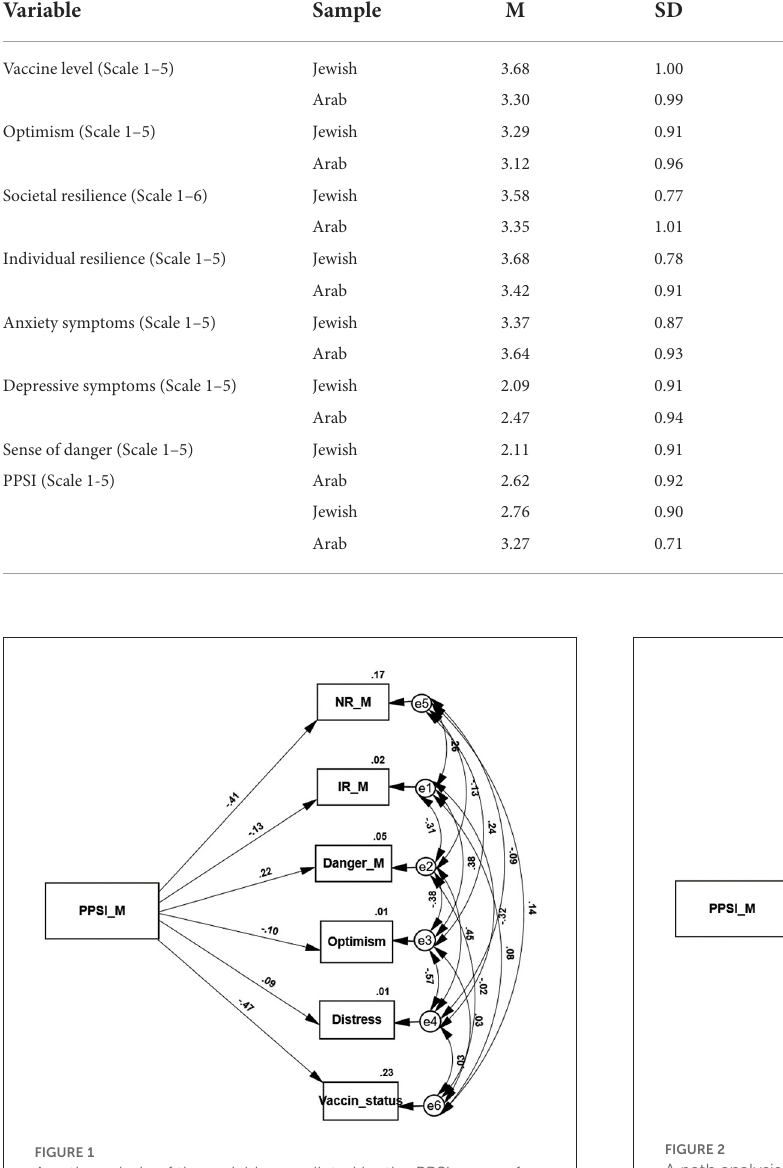
TABLE 2 Analysis of variance (ANOVA) comparing the psychological responses of Israeli Jewish ( n = 600) and Arab ( n = 208) respondents. Variable